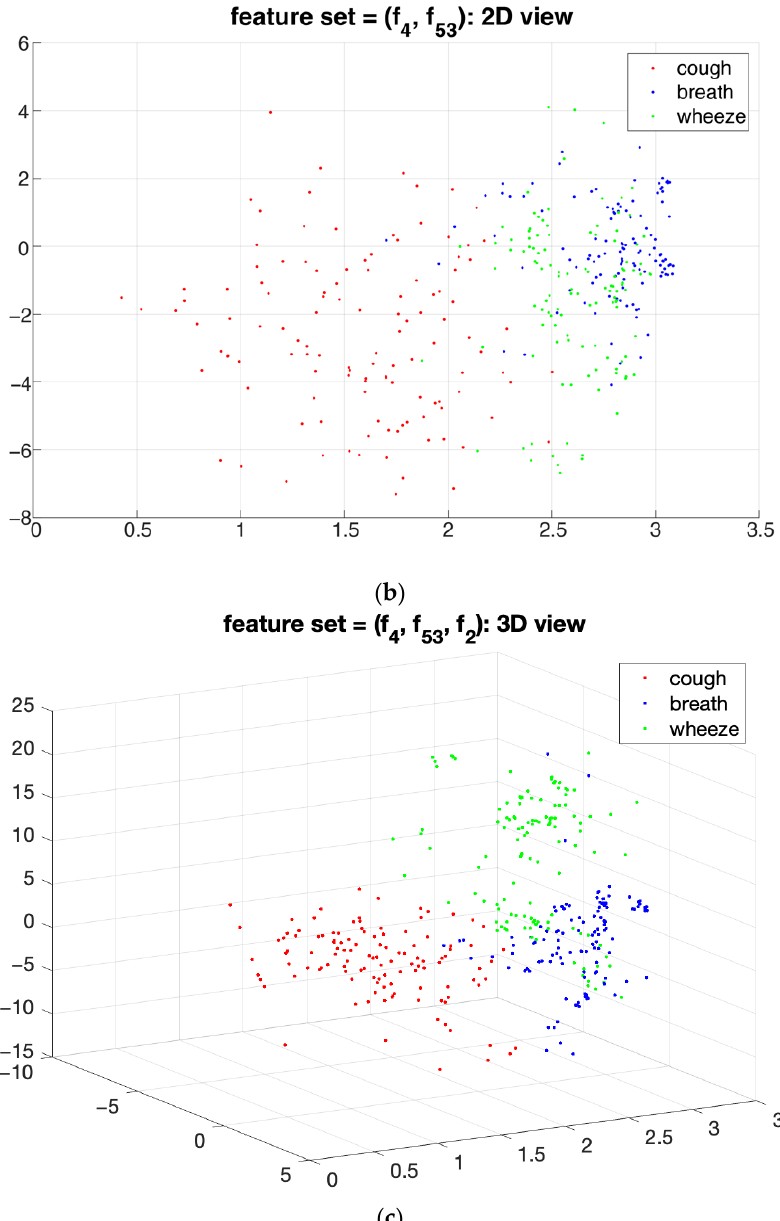
Figure 5. Distribution of cough, breath, and wheeze data in ( a ) 1-dimensional feature space where the x-axis is the sample index, ( b ) 2-dimensional feature space, and ( c ) 3-dimensional feature space. The feature space is constructed by recursively adding features into feature subsets according to Algorithm 1. Each dot represents an acoustic segment of cough (red), breath (blue), or wheeze (green)